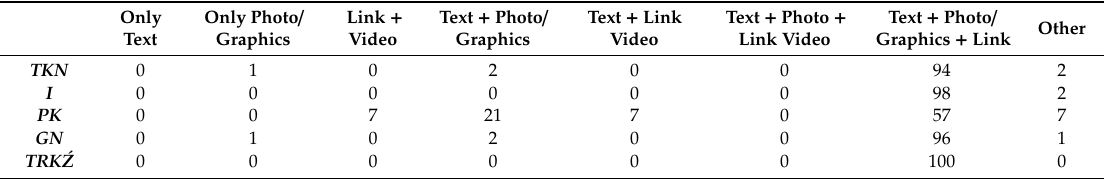
Table 7. Form of posts published on FB (%).